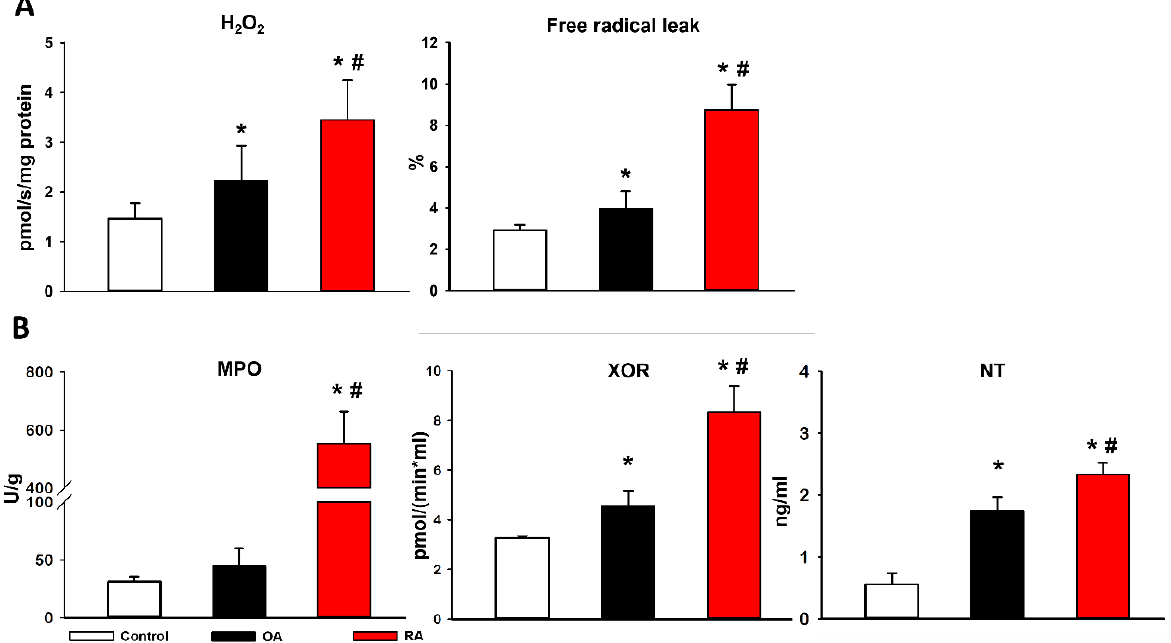
Figure 3. ( A ) Mitochondrial reactive oxygen species (ROS) production. The left chart demonstrates the mitochondrial H 2 O 2 release as a marker of reactive oxygen species (ROS) (i.e., superoxide anion) production, monitored fluorimetrically with the Amplex Red/horseradish peroxidase system. The right chart shows the free radical leak as the percentage of oxygen consumption diverted to the production of H 2 O 2 in OxPhos state. ( B ) Biochemical analyses of synovial tissue. The charts demonstrate myeloperoxidase (MPO), xanthine oxidoreductase (XOR), and nitrotyrosine (NT) enzyme activities. Black represents the OA group. The control group is marked with white. Data are presented as means ± SD. * p < 0.05 vs. control; # p < 0.05 vs. OA (one-way ANOVA, Tukey’s test ).